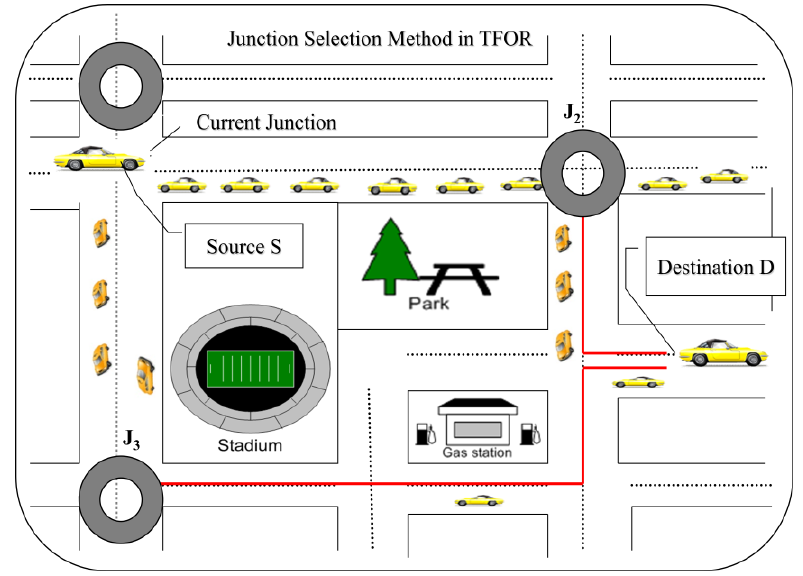
Figure 9. Junction Selection Method in Traffic Flow Oriented Routing Protocol TFOR.